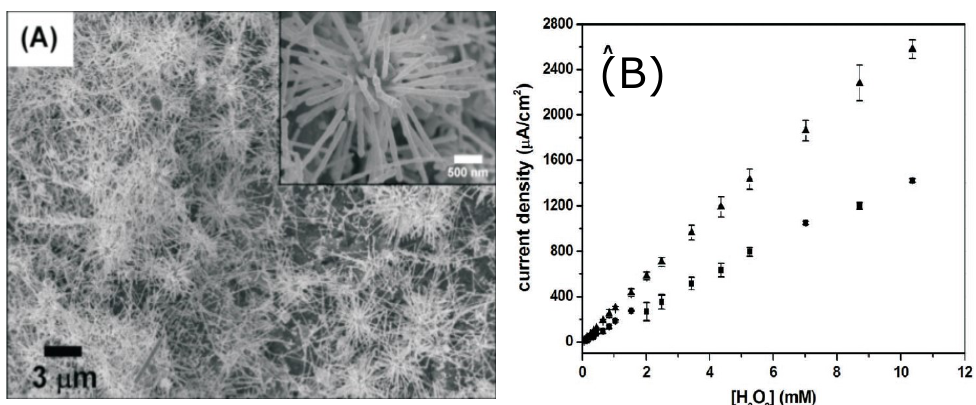
Figure 4. ( A ) SEM image of Ag urchin-like NWs on an SPC electrode (inset: enlarged view of a single cluster of urchin-like Ag NWs; ( B ) calibration curves of amperometric tests. Adapted with permission from [9].